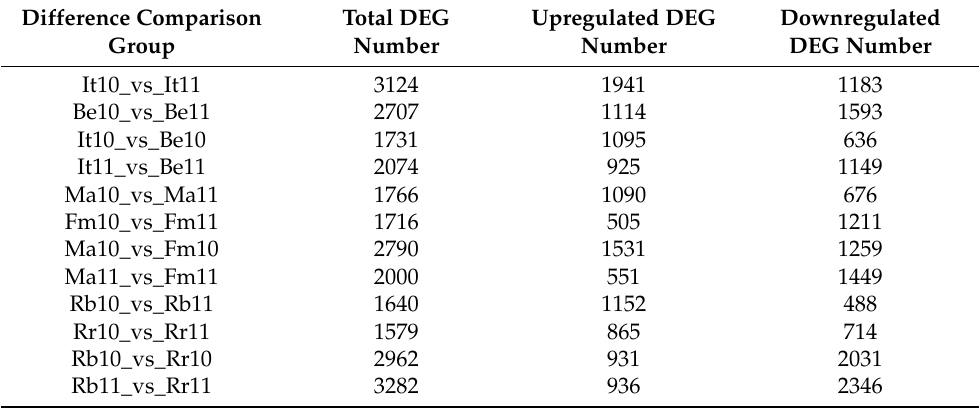
Table 2. The numbers of DEGs among difference comparison